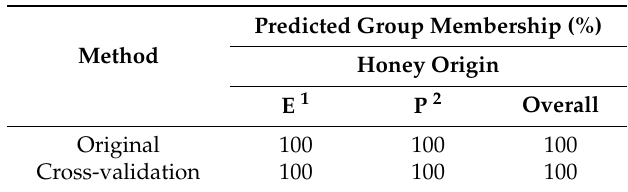
Table 4. Classification of Uruguayan honey samples of different environmental origin and percentage of correctly classified observations using discriminant